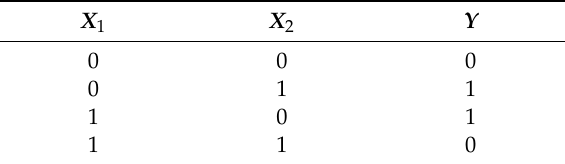
Table 7. Exclusive disjunction (XOR) function truth